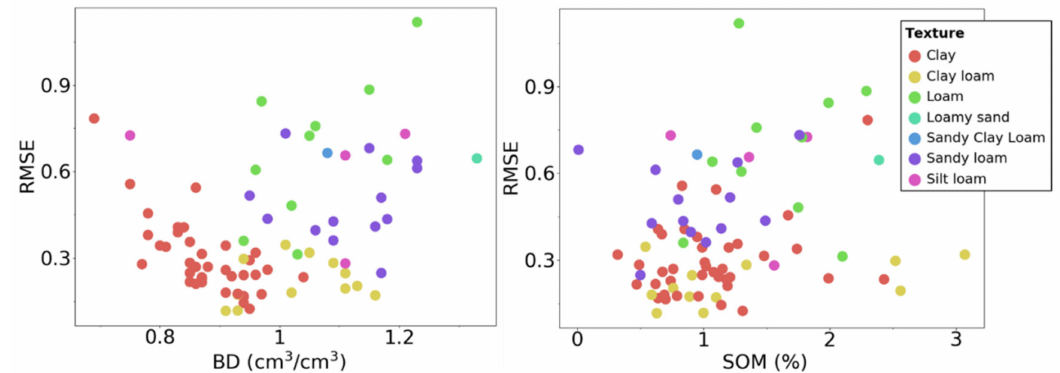
Figure 4. The root of mean squared error (RMSE) as a function of bulk density (BD) and organic matter content (SOM) for the PC NN PTF Model 1 with SSC, BD, SOM as inputs. The model was developed using combined international and Turkish data sets and tested using the Turkish data set (scenario 4). The error was calculated for each soil sample